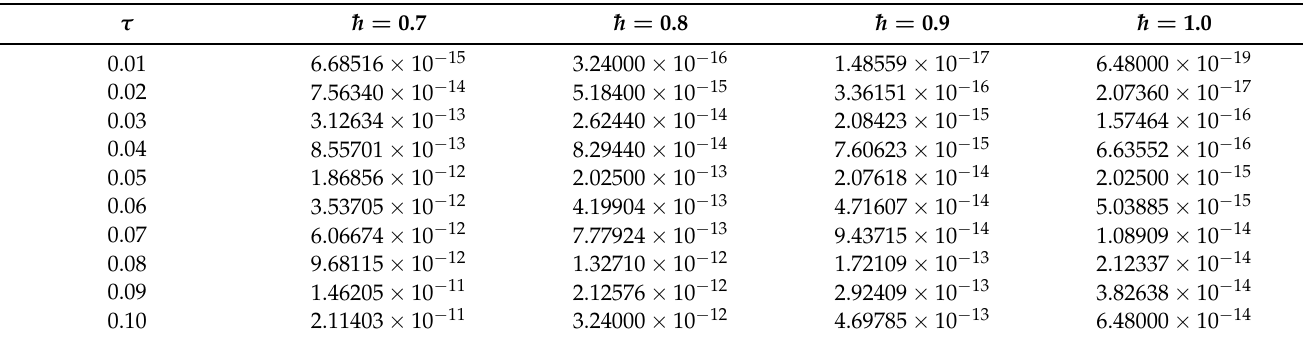
Table 5. The | Ω 5 ( α , τ ) − Ω 4 ( α , τ ) | of Problem 2 at varying values of ¯ h at α = 1.0 determined by the ARPSM at plausible locations in the range τ ∈ [ 0, 0.10 ] .